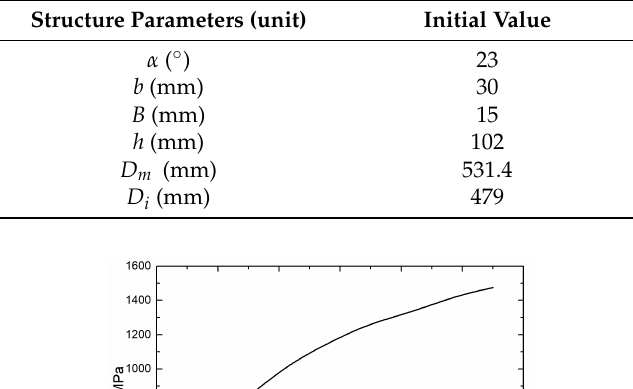
Table 1. The initial structure parameters of the VX gasket.